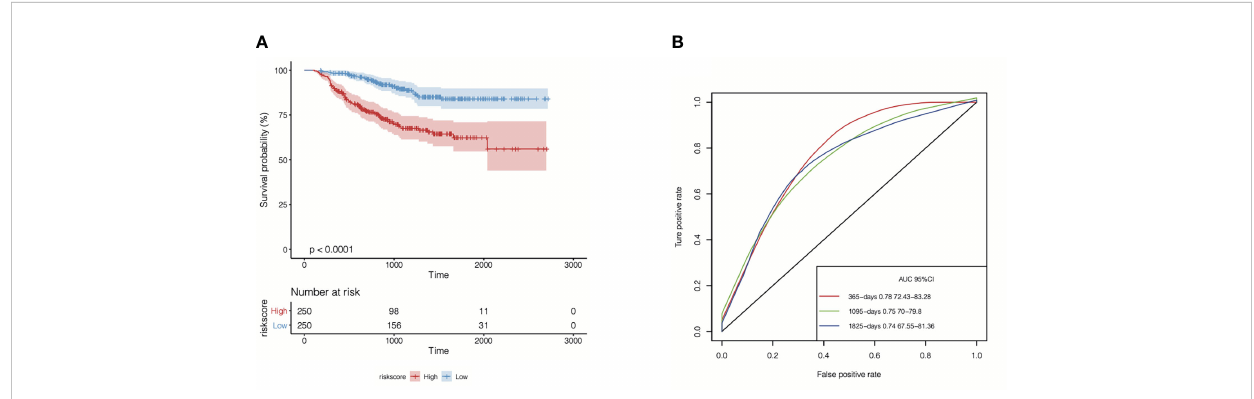
FIGURE 4 Overall survival analysis of TILCD8TSig in GSE25066. (A) Kaplan-Meier analysis of the TILCD8TSig subgroups in GSE25066 cohort. (B) ROC analysis of TILCD8TSig on DRFS at 1-,3-, and 5-years follow up in GSE25066